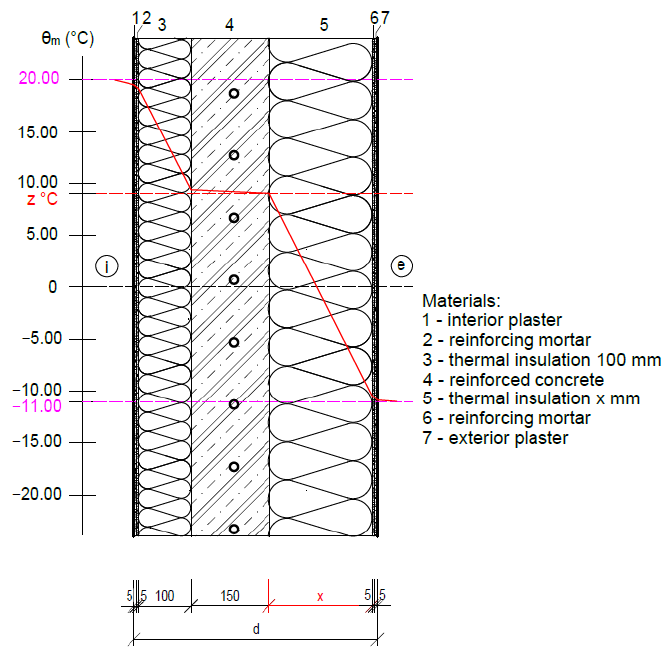
Figure 12. Our upgraded ISOMAX perimeter wall construction. θ m —the temperature in construction (°C), d—construction thickness (mm), x—thickness of thermal insulation, z—the temperature between the load-bearing and thermal insulation layer of the structure (°C), e—exterior, and i— interior. The calculated internal temperature in the ATP placement layer is θ m = 3.91 ◦ C